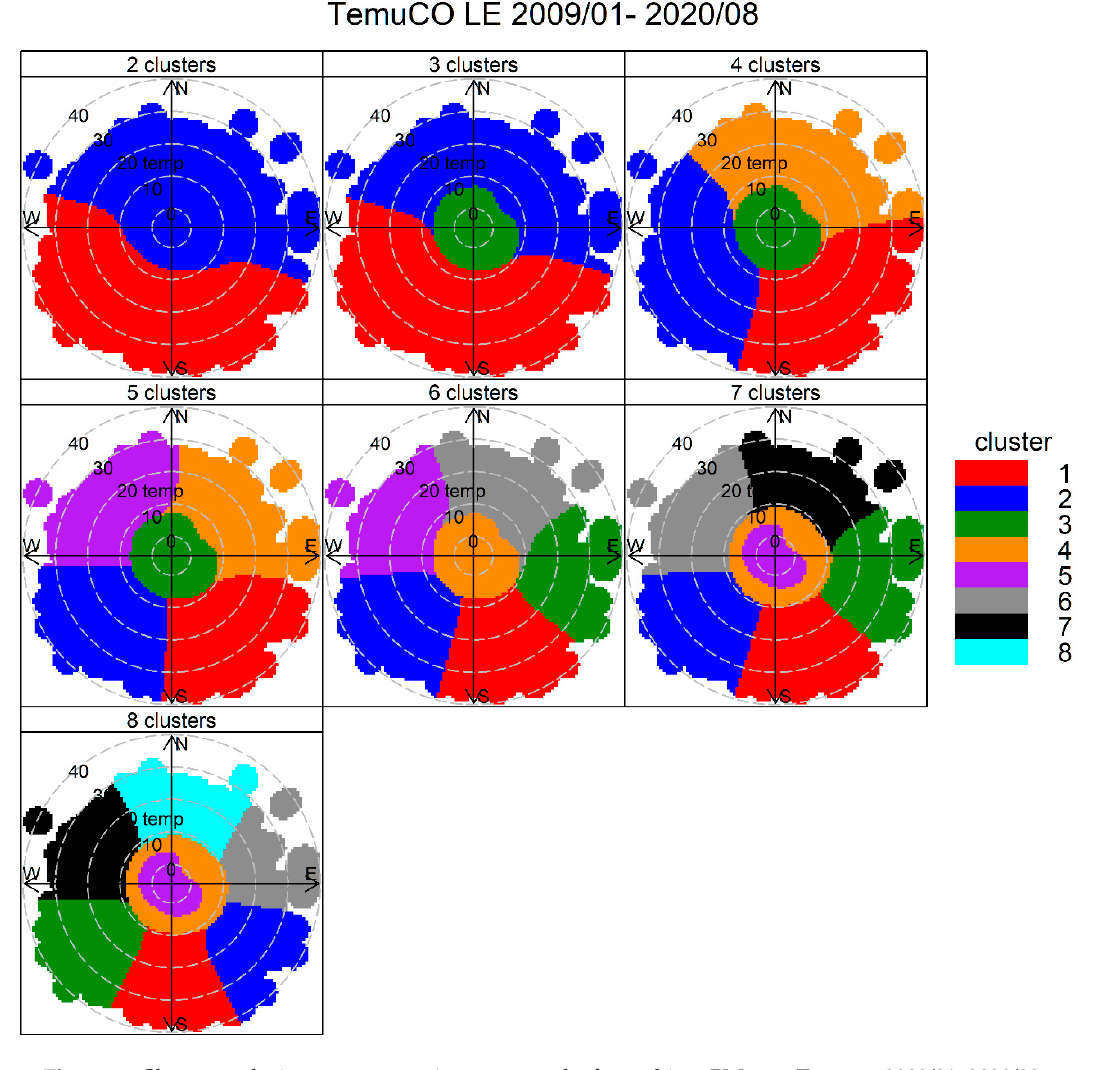
Figure 7. Cluster analysis source apportionment results for ambient PM 2.5 at Temuco, 2009 / 01–2020 / 08, for 2–8 cluster solution.